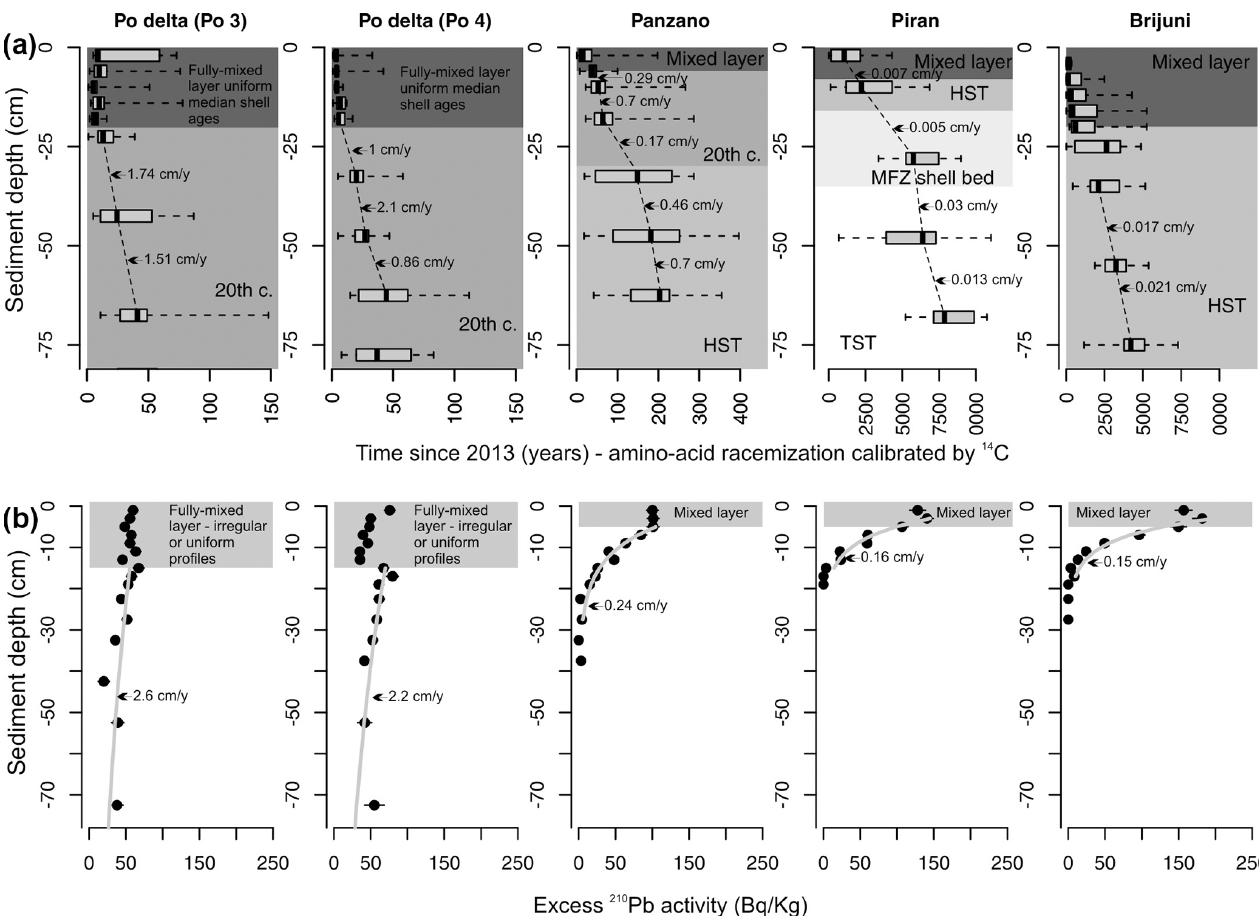
Figure 3. Downcore changes in shell ages (a) and the excess in 210 Pb profiles (b) that form the basis for inferences about the depth of the mixed layer (absence of downcore changes in median shell age in the uppermost parts of cores and irregular or uniform segments of the 210 Pb excess) and the sedimentation rate (thickness deposited over a duration defined by differences in median ages and the slope of the 210 Pb segments below the mixed layer in gray). We note that some variability in these estimates is also affected by biomixing when the thickness of sediments over which the deposition is measured is too low relative to the thickness of the mixed layer, leading to overestimation of the sedimentation